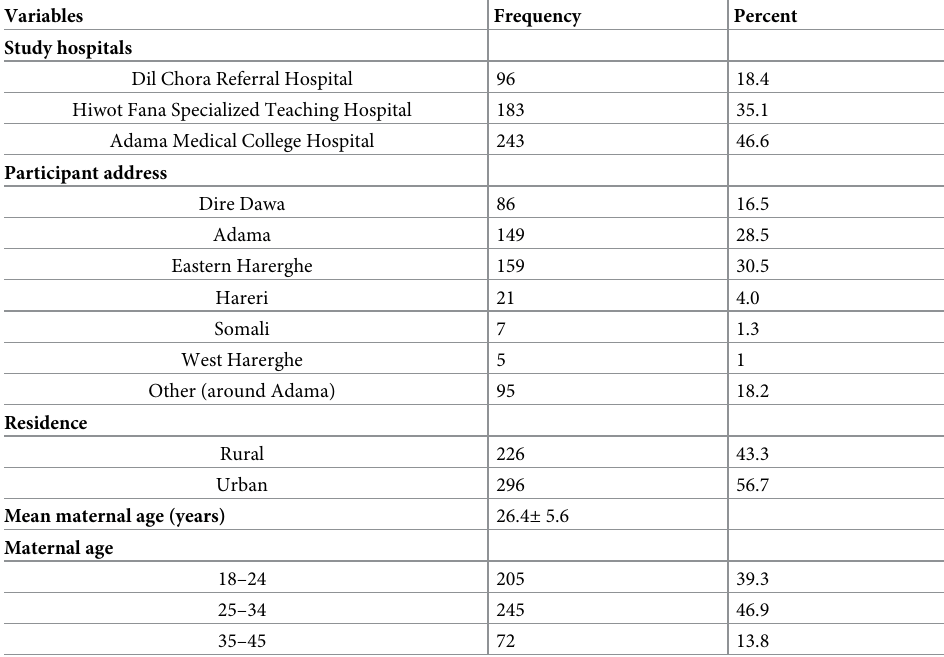
Table 1. Background characteristics and proportion of deliveries with NTDs in the Eastern Ethiopia based on hospital data from 2017–2019.